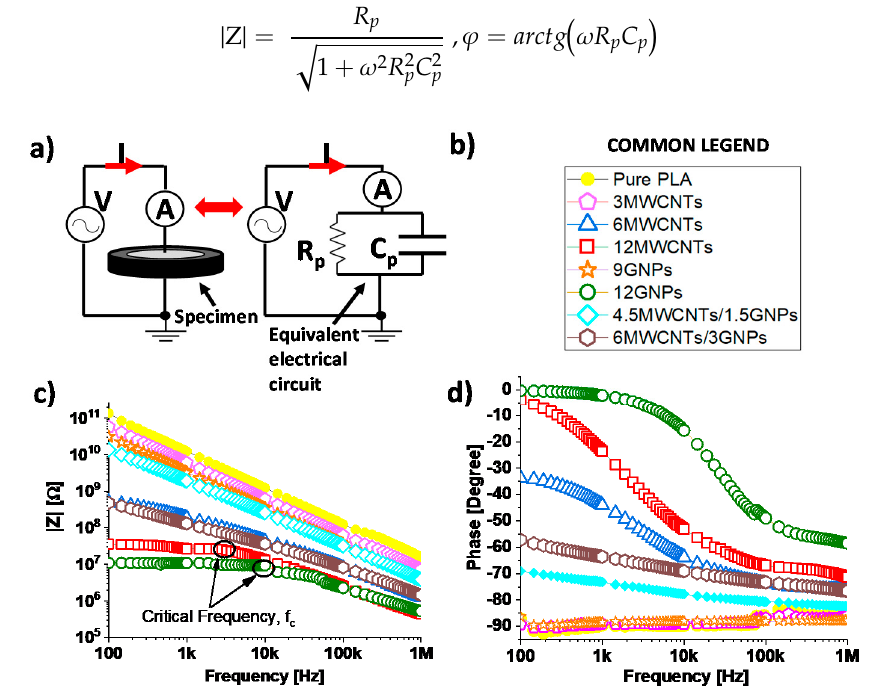
Figure 14. ( a ) Equivalent electrical circuit proposed for the specimen under test. ( b ) Some specific formulations selected for the impedance spectroscopy. Modulus and phase impedance, in ( c ) and ( d ) respectively, evaluated in the frequency range of 100 Hz–1 MHz.